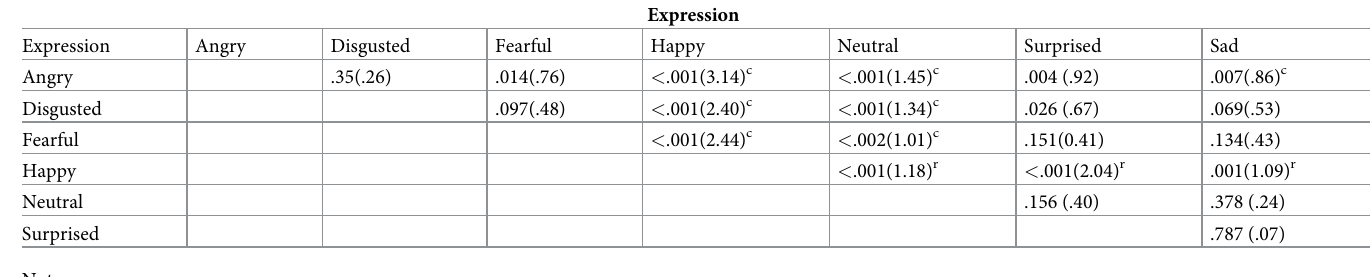
Table 1. P values and effect sizes (in parentheses) from paired-sample t-tests between each pair of expressions at central fixation, for the recognition